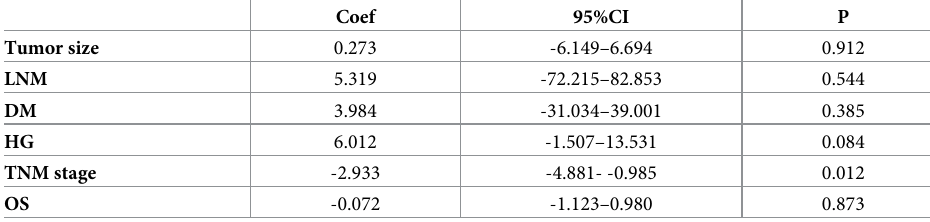
Table 3. The publication bias test including